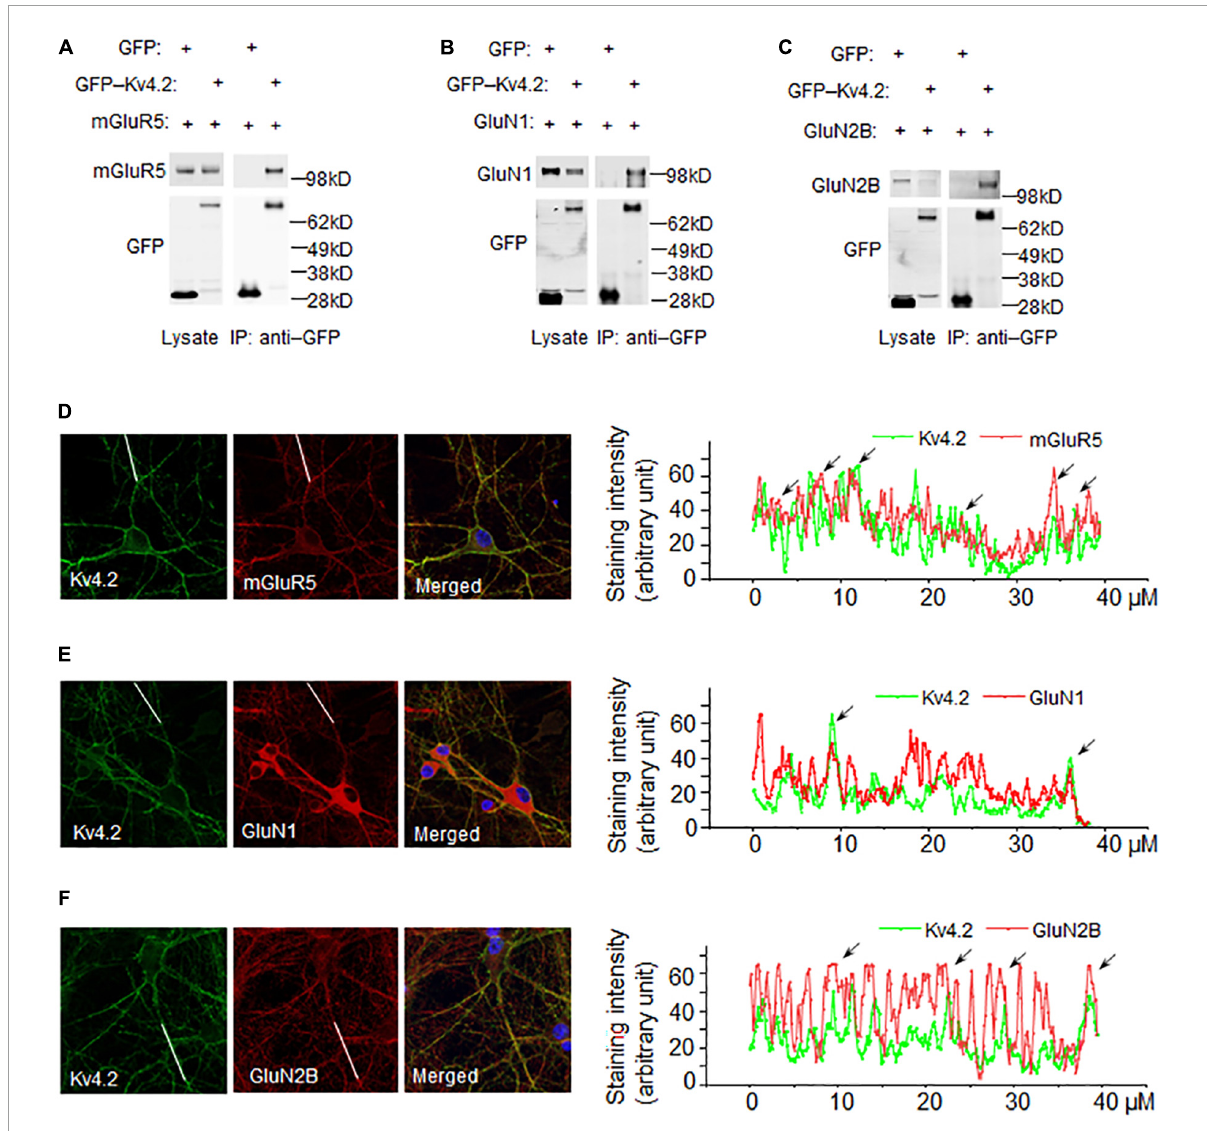
FIGURE3 Co-immunoprecipitation and co-localization of Kv4.2 with novel interacting proteins. (A) mGluR5 binds to Kv4.2. GFP-Kv4.2 and HA-mGluR5 were co-transfected into HEK-293T cells. Detergent lysates were incubated with anti-GFP antibody and analyzed by western blotting with anti-GFP and anti-HA antibodies. (B) GluN1 binds to Kv4.2. GFP-Kv4.2 and HA-GluN1 were co-transfected into HEK-293T cells. Detergent lysates were incubated with anti-GFP antibody and analyzed by western blotting with anti-GFP and anti-GluN1 antibodies. (C) GluN2B binds to Kv4.2. GFP-Kv4.2 and HA-GluN2B were co-transfected into HEK-293T cells. Detergent lysates were incubated with anti-GFP antibody and analyzed by western blotting with anti-GFP and anti-HA antibodies. (D) mGluR5 colocalized with Kv4.2. mGluR5 and Kv4.2 were antibody-stained in cultured DIV14 hippocampal neurons. Line scan along the dendrites showed mGluR5 and Kv4.2 are colocalized as indicated with arrows. (E) GluN1 colocalized with Kv4.2. GluN1 and Kv4.2 were antibody-stained in cultured DIV14 hippocampal neurons. Line scan along the dendrites showed GluN1 and Kv4.2 are colocalized as indicated with arrows. (F) GluN2B colocalized with Kv4.2. GluN2B and Kv4.2 were antibody-stained in cultured DIV14 hippocampal neurons. Line scan along the dendrites showed GluN2B and Kv4.2 are colocalized as indicated with